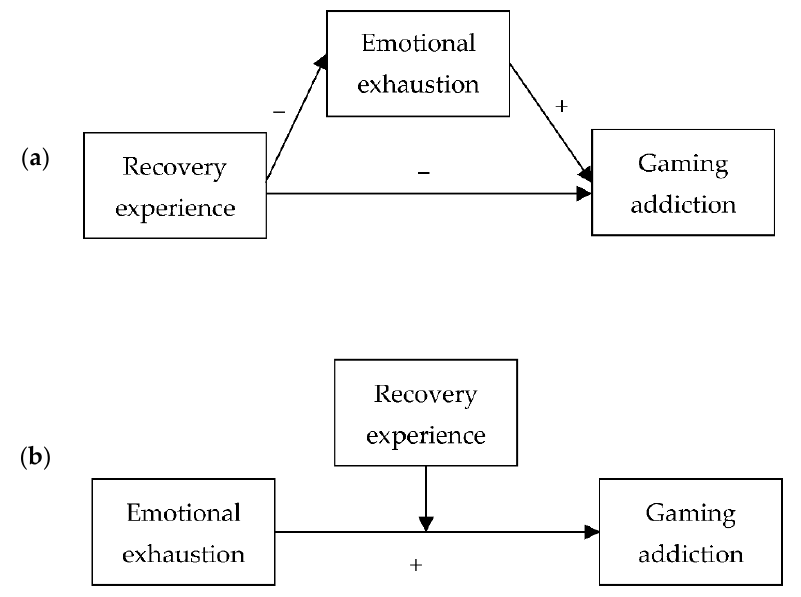
Figure 1. ( a ). The proposed mediation model. ( b ). The proposed moderation